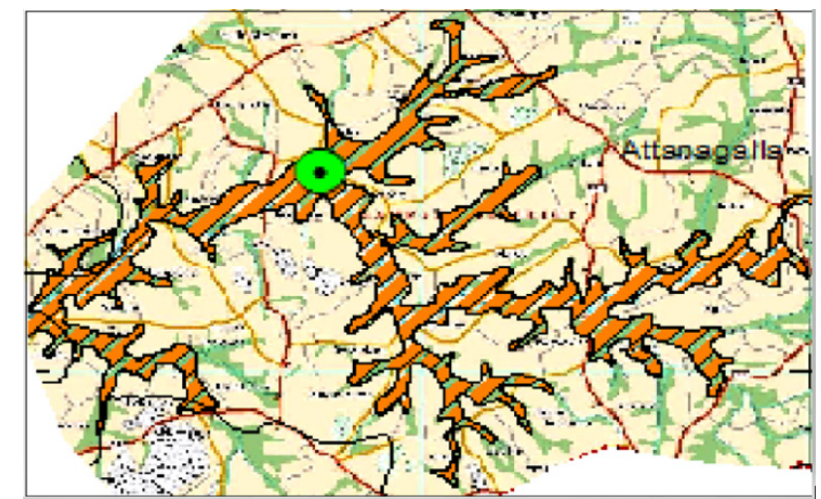
Figure 4: Actual flood area for the flood events occurred in May